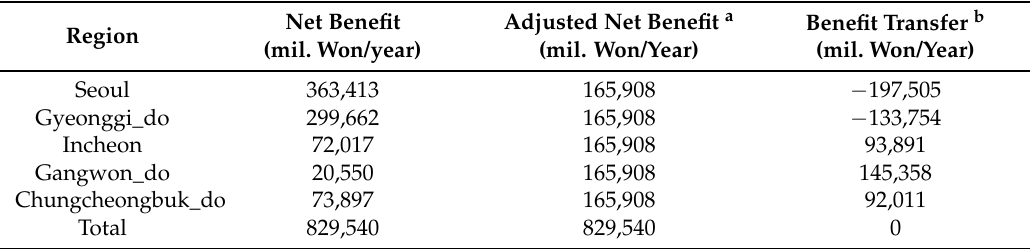
Table 9. Recalculation of net benefit transfer associated with decrease in households’ income in mid- and downstream